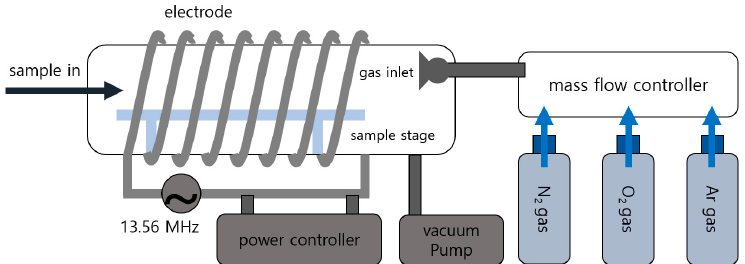
Figure 1. A schematic diagram of a low-pressure plasma treatment system to generate various wrinkle structures.